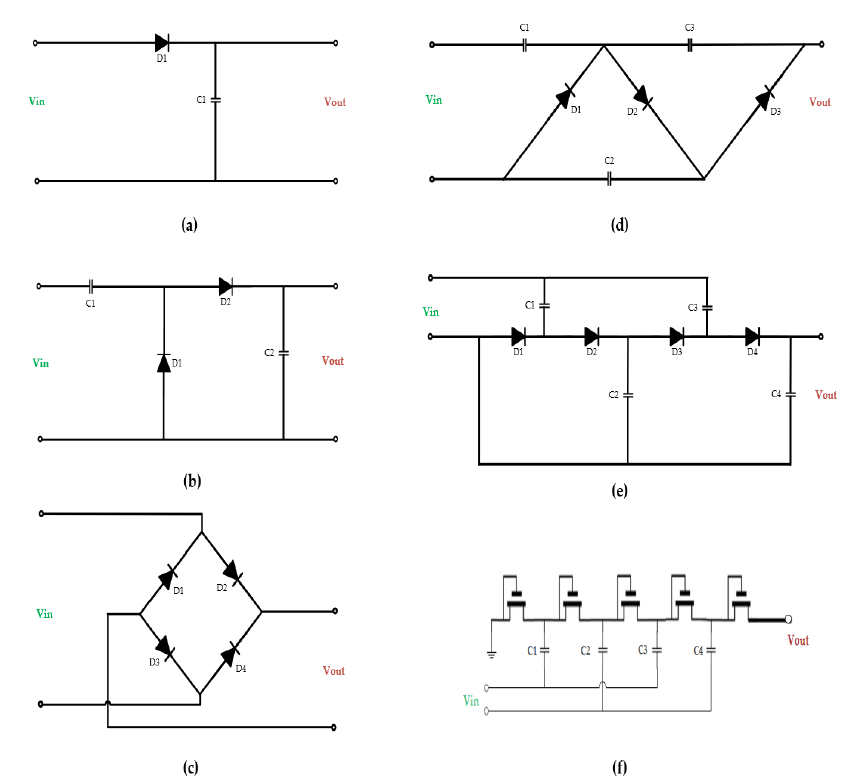
Figure 5. Various rectifier topologies: ( a ) circuit diagram of half-wave rectifier; ( b ) circuit diagram of full-wave rectifier; ( c ) circuit diagram of bridge rectifier; ( d ) circuit diagram of three-stages Cockcroft– Walton voltage multiplier; ( e ) circuit diagram of four-stages Dickson voltage multiplier; ( f ) circuit diagram of four-stages Dickson voltage multiplier utilizing CMOS